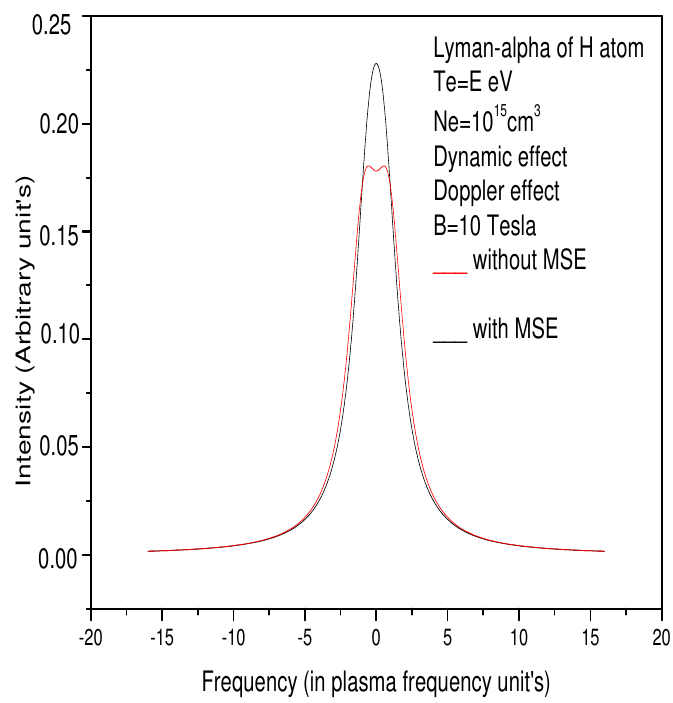
Figure 4. Lyman Alpha line in the hydrogen plasma: A comparison between with and without the MSE. With the Doppler effects and without the fine structure effect. The same plasma conditions are the same as Figure 3.